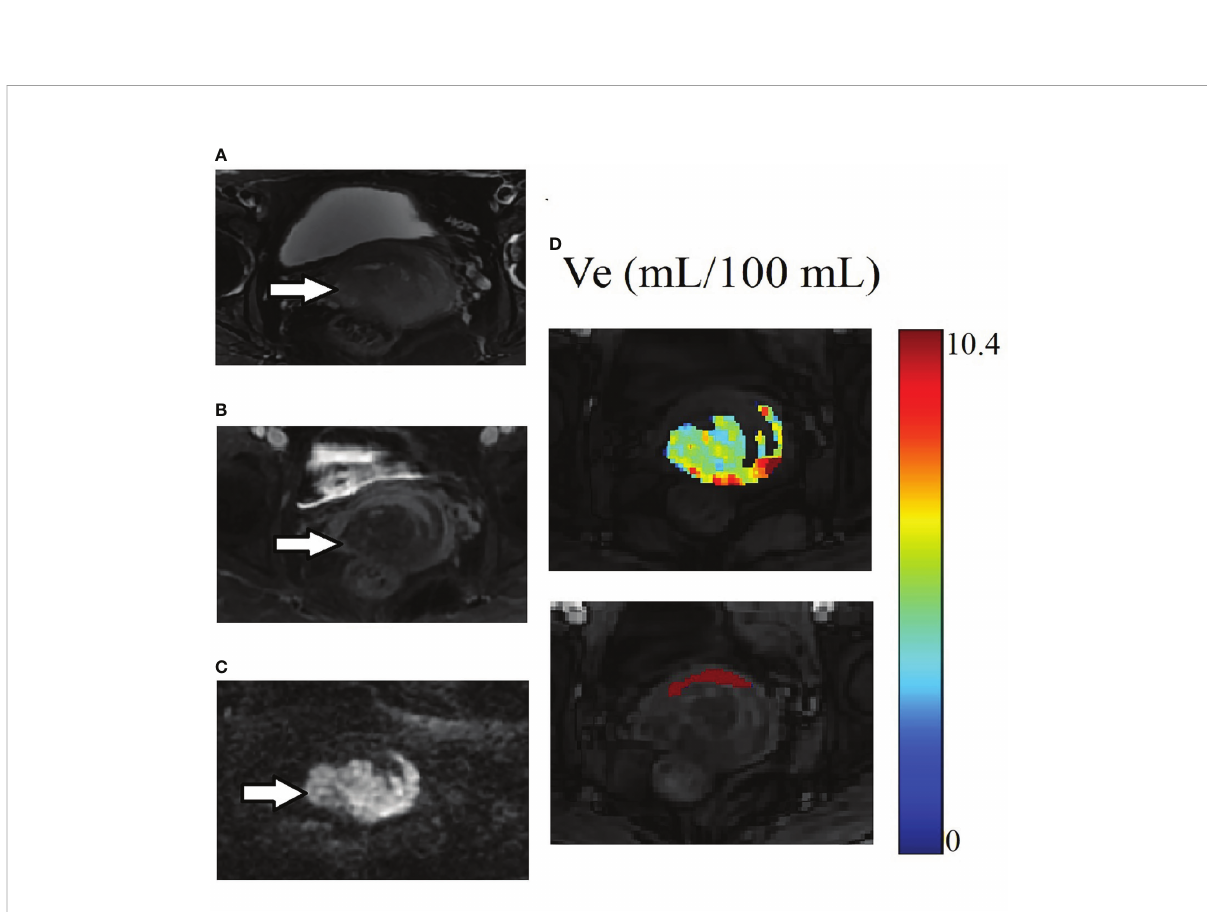
FIGURE 5 Example of MRI scans for the same patient in Figure 3. (A) Cervix cancer exhibits slightly high signal intensity on axial T2-weighted image. (B) The degree of enhancement for cervix cancer is lower than the normal cervix tissue on delayed contrast imaging. (C) Cervix cancer exhibits high signal intensity on DW image. (D) The parameter Ve maps generated using the ATH model for cancer and the normal tissue ROIs. The upper and lower images are for cancer and the normal tissue ROIs respectively. Parameter Ve value of cervix cancer is signi fi cantly smaller than that of normal cervix